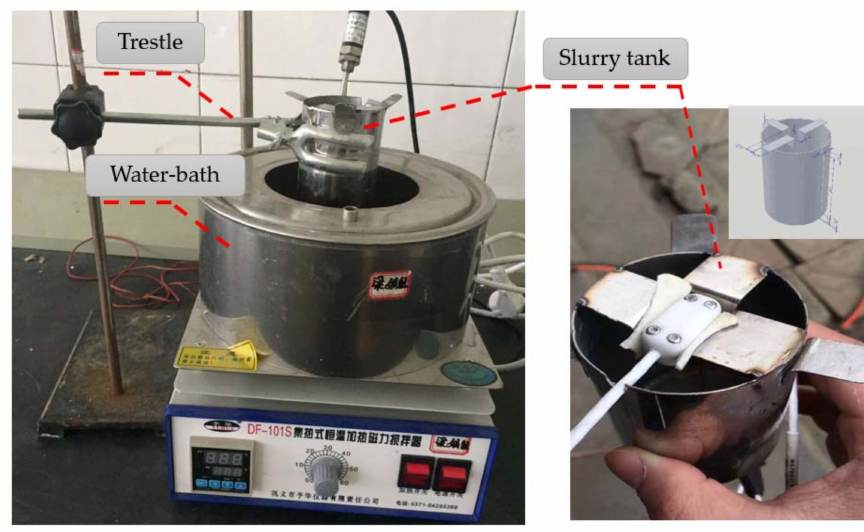
Figure 6. The thermal conductivity experiment rig.